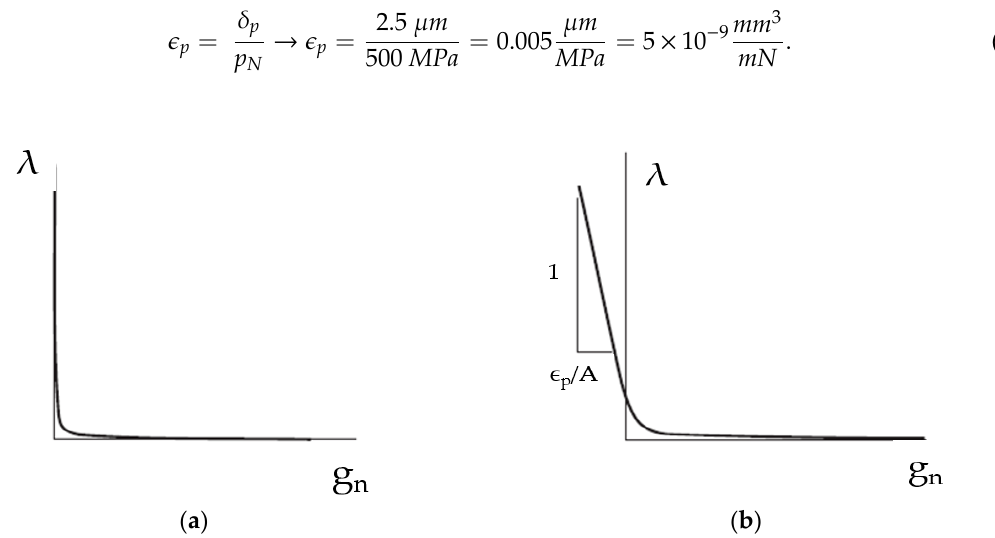
Figure 6. ( a ) Constraint function without contact compliance; ( b ) constraint function with contact compliance, according to the method described in [23].